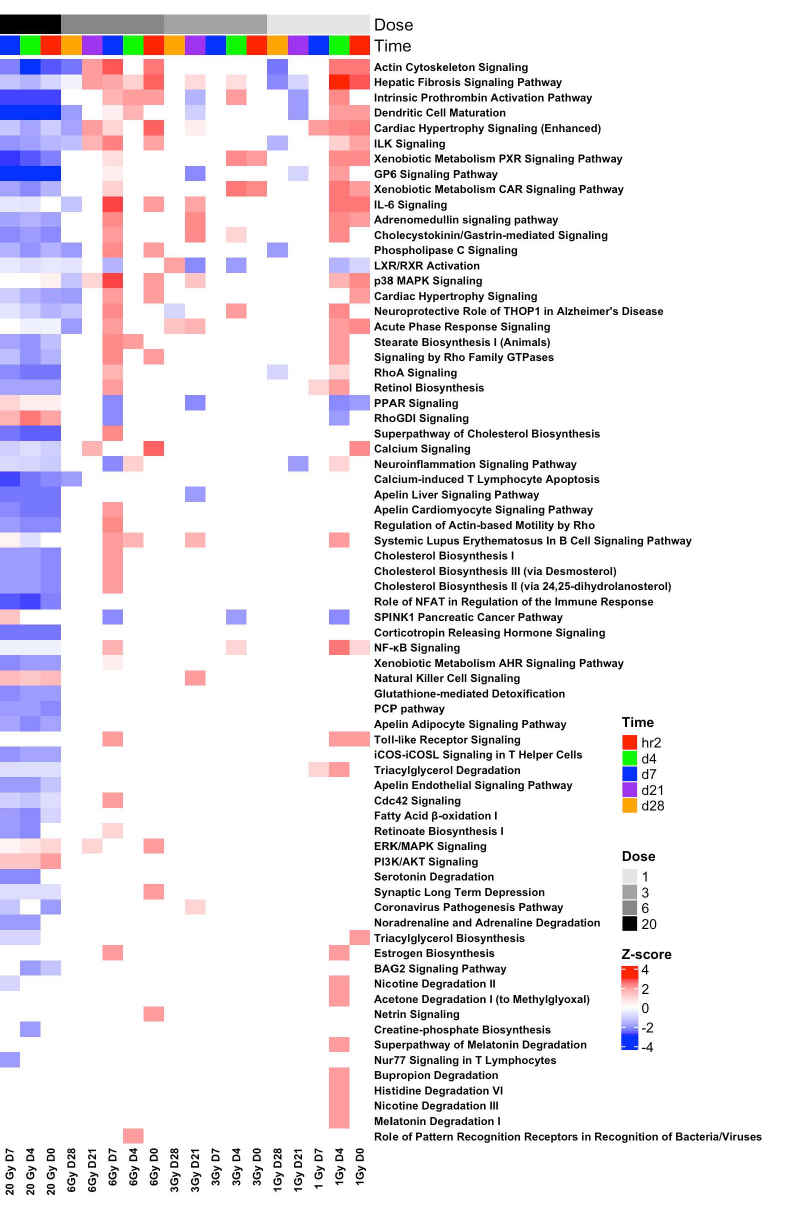
Figure 9. Significantly (Abs z-score ≥ 2 and − log p ≥ 1.3) modulated pathways in at least one time point from the analysis of SDTGs ( p ≤ 0.05 and Abs FC ≥ 2) in all TPs and all IR doses. A total of 71 pathways were identified to be modulated at 202 assessment points, of which, 107 were inactivation and 81/107(or 76%) were associated with TPs of the 20 Gy exposure. Blue color for inactivation and orange for activation prediction. Color darkens with increased modulation intensity. All significantly identified pathways were modulated oppositely in lethal and sub- lethal doses, with the vast majority being inactivated at a lethal dose (20 Gy) and either activated or not present at the sublethal doses (1, 3, and 6 Gys), and only the RhoGDI signaling and the PIK/AKT signaling pathways were found to be activated at d4 and 2 h, respectively, after the lethal dose and were predicted inactivated or not present at sublethal